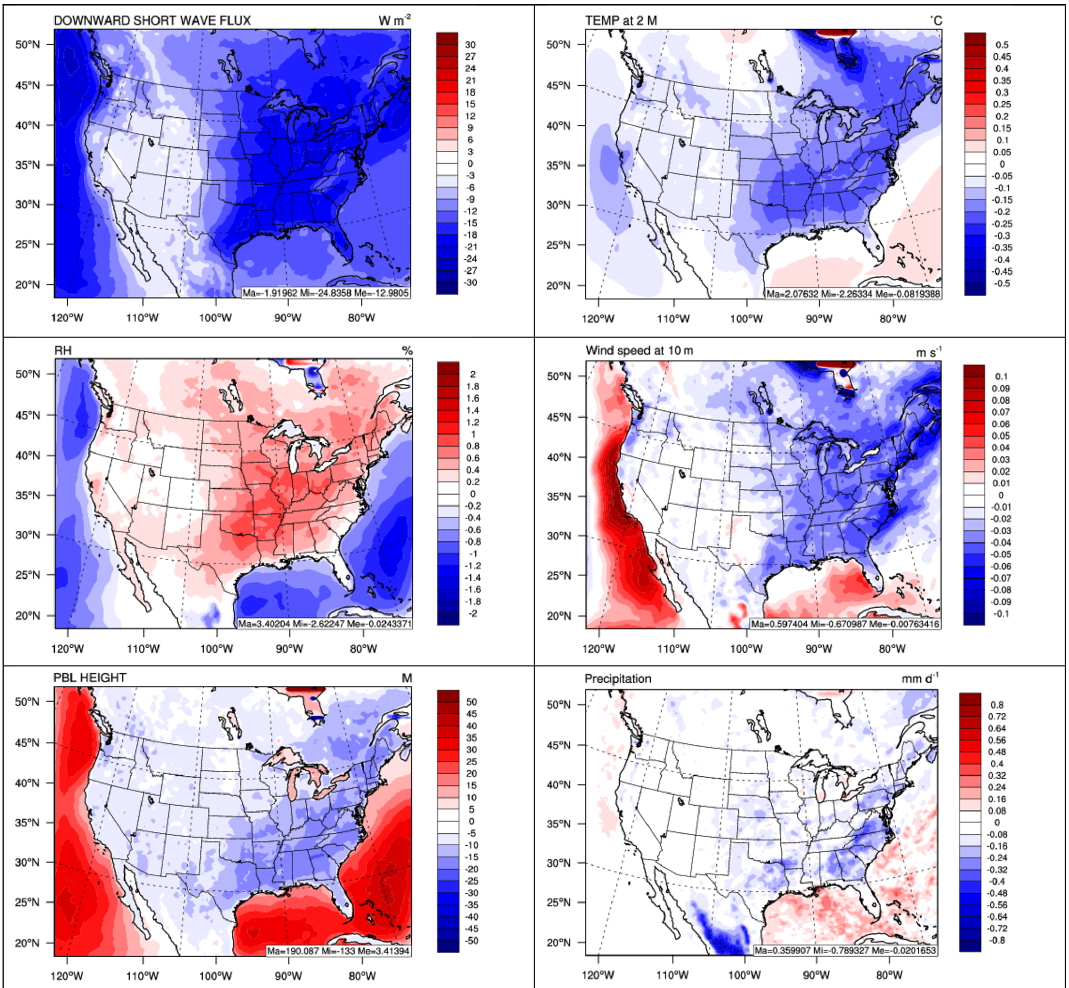
Figure 15. Spatial difference plots (two-way WRF-CMAQ–WRF-only) for major meteorological variables between two-way WRF-CMAQ and WRF-only in